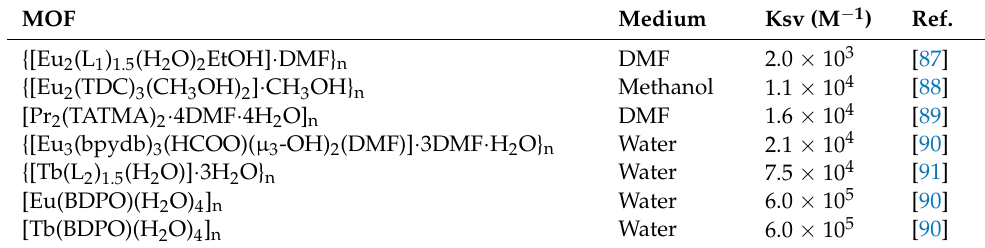
Table 3. Results for the sensing of TNP for other lanthanide-based